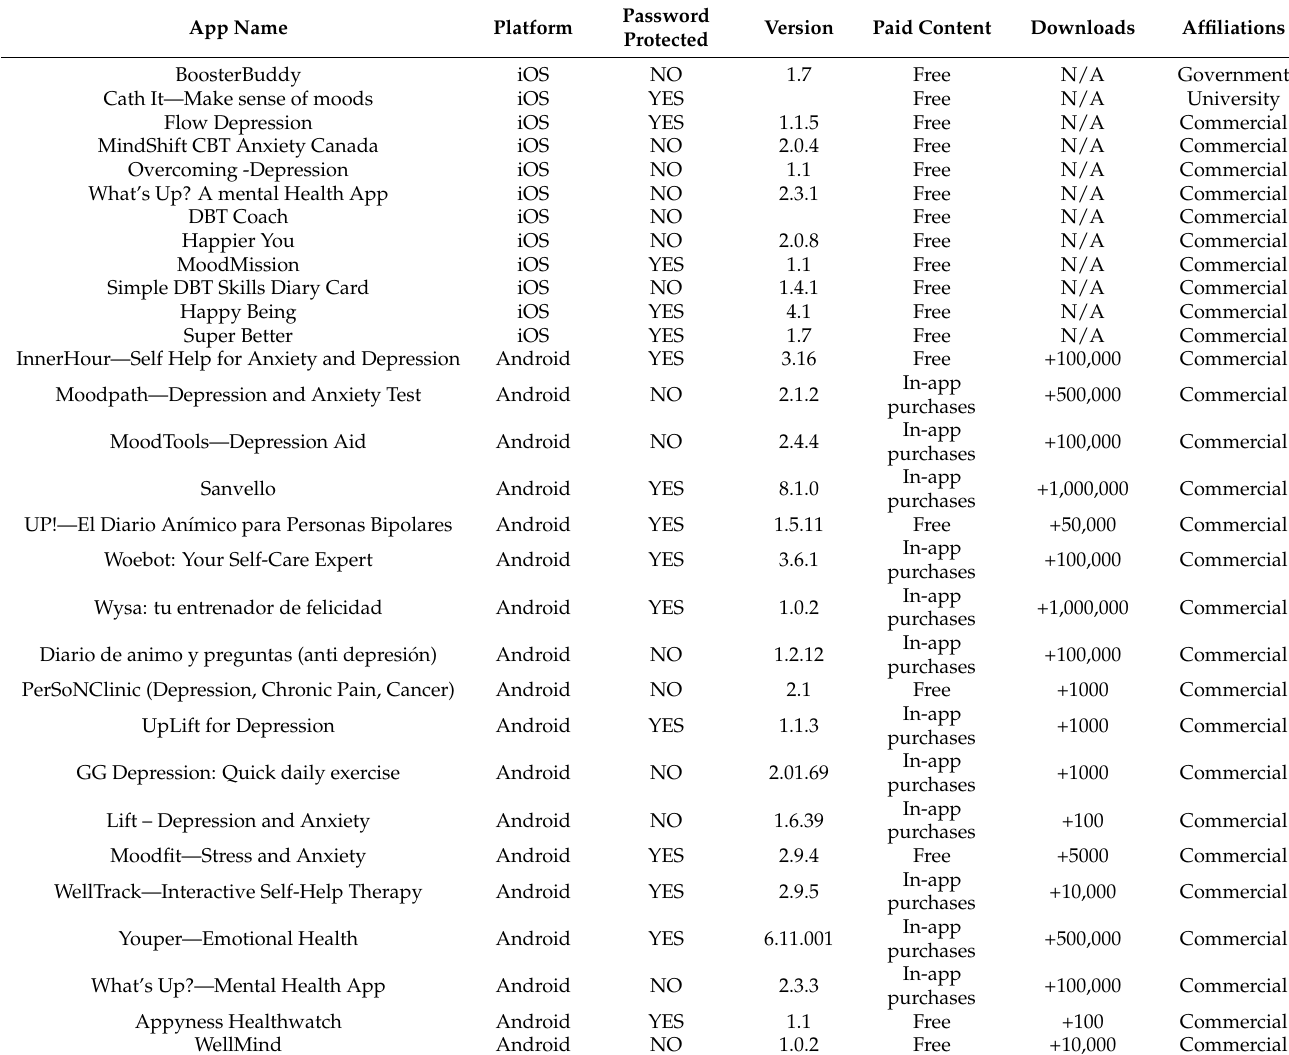
Table 1. Description of the apps included in the